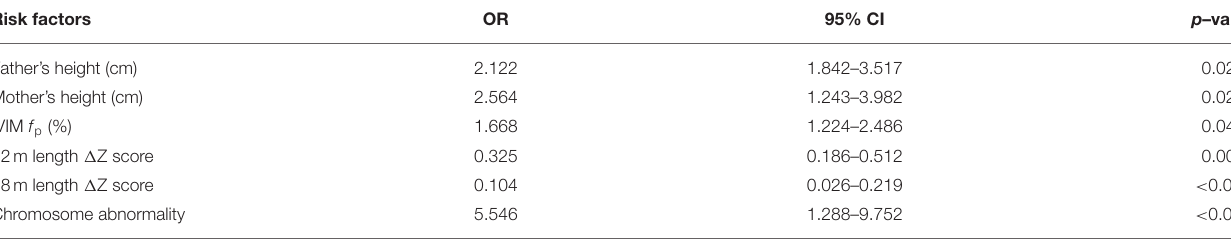
TABLE 5 | Multivariate analysis of risk factors for short stature in children born SGA at